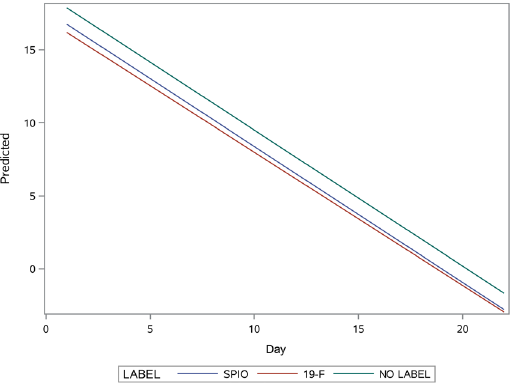
Figure 6. Regression analysis with predicted values of cell death for the imaging methods plotted versus time, expressed as